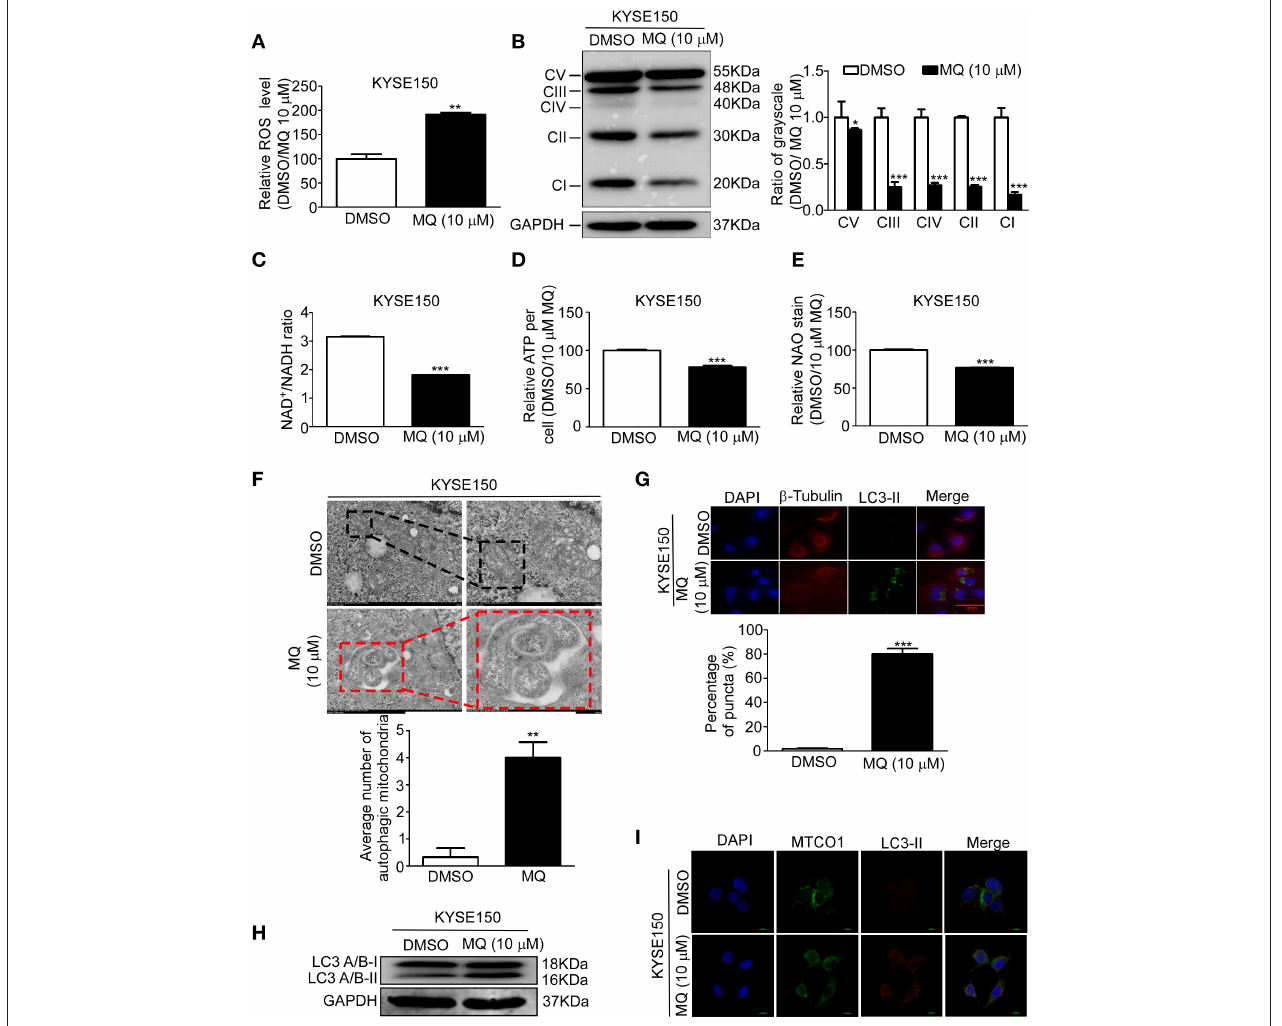
FIGURE 4 | Mefloquine induces mitochondrial autophagy of KYSE150 cells. (A) ROS generation in KYSE150 cells after DMSO and MQ (10 µ M) treatment for 24h was measured with ROS assay kit; (B) KYSE150 cells probed for OXPHOS protein levels (complexes I, II, III, IV, and V) after DMSO or MQ (10 µ M) treatment for 24h; (C) NADH was quantified in KYSE150 cells after DMSO and MQ (10 µ M) treatment for 24h by NAD + /NADH assay kit; (D) ATP generation was tested in KYSE150 cells after DMSO and MQ (10 µ M) treatment for 24h by ATPlite assay kit; (E) Mitochondrial mass was evaluated with NAD staining in mitochondria after DMSO and MQ (10 µ M) treatment for 24h; (F) KYSE150 cells were photographed by transmission electron microscopy after DMSO or MQ (10 µ M) treatment for 24h. Three electron microscopy pictures were randomly chosen, and the number of autophagic mitochondria was counted. Black boxes indicate the normal mitochondria, and red boxes indicate the autophagosomes engulfing mitochondria. Scale = 500nm; (G) LC3-II labeling for autophagic mitochondria after 24h of DMSO or 10 µ M MQ treatment by immunofluorescence analysis; (H) Western blot for LC3A/B in KYSE150 cells after DMSO and MQ (10 µ M) treatment for 24h; (I) Co-localization analysis of MTCO1 and LC3-II in KYSE150 cells after DMSO and MQ (10 µ M) treatment for 24h by immunofluorescence